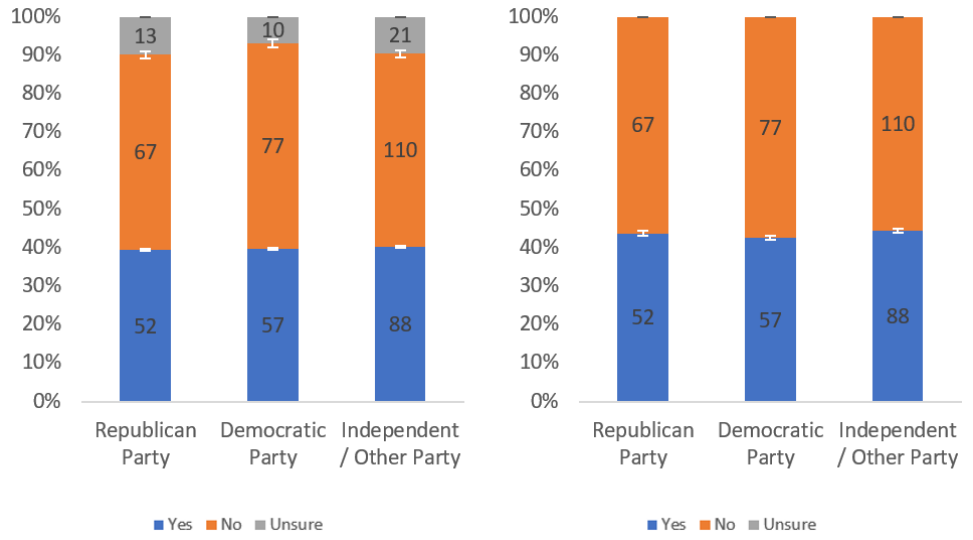
Figure 11. Responses regarding label annoyingness by political affiliation including ( left ) and ex- cluding ( right ) unsure responses.